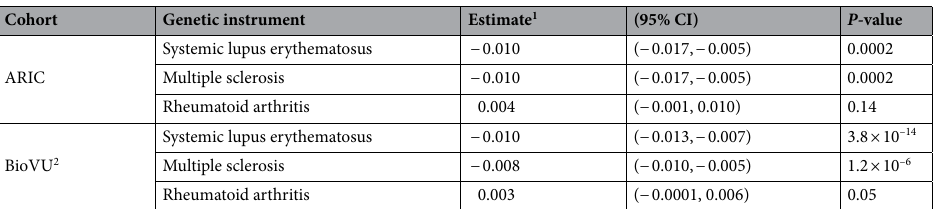
Table 2. Associations between autoimmune polygenic risk scores and measured transformed white blood cell counts in ARIC and BioVU. CI confidence interval. 1 Change in log transformed white blood cell count per standard deviation change in the polygenic risk score odds of the autoimmune disease, adjusted by sex, age, and 10 principal components. 2 BioVU included only participants without a diagnosis of each autoimmune